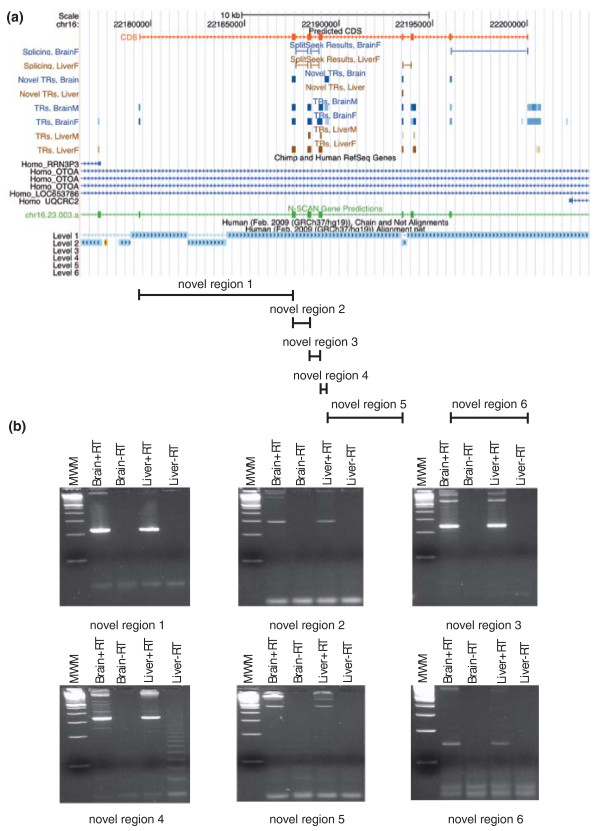
Example of a previously uncharacterized gene. (a) A view from the UCSC Genome Browser displaying the predicted novel gene, located within an intron in the OTOA gene. At the top is a schematic drawing of the gene with exons shown as red boxes. Then follows two tracks with predicted splice junctions and a set of tracks with TRs, shown separately for each tissue. Below are schematic models of human RefSeq genes (in blue) and an N-SCAN gene prediction (in green) in the region. At the bottom is the structure of the human genome, showing the genomic rearrangement affecting exon five in the novel gene. (b) The results of the experimental validation with RT-PCR. Each gel represents one exon-exon junction. The first lane on the gels from the left is a 100-bp ladder (molecular weight marker, MWM), then follows the brain sample with (+RT) and without (-RT) reverse transcriptase, followed by the same set of experiments in the liver sample. Some of the PCR products are longer than expected, indicating that some of the exons are longer than initially predicted or that there may be additional exons in the gene model.